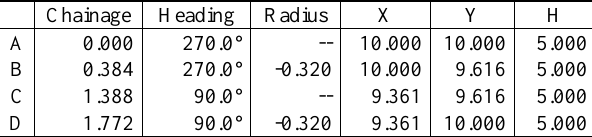
Table 1. Track alignment of the railway